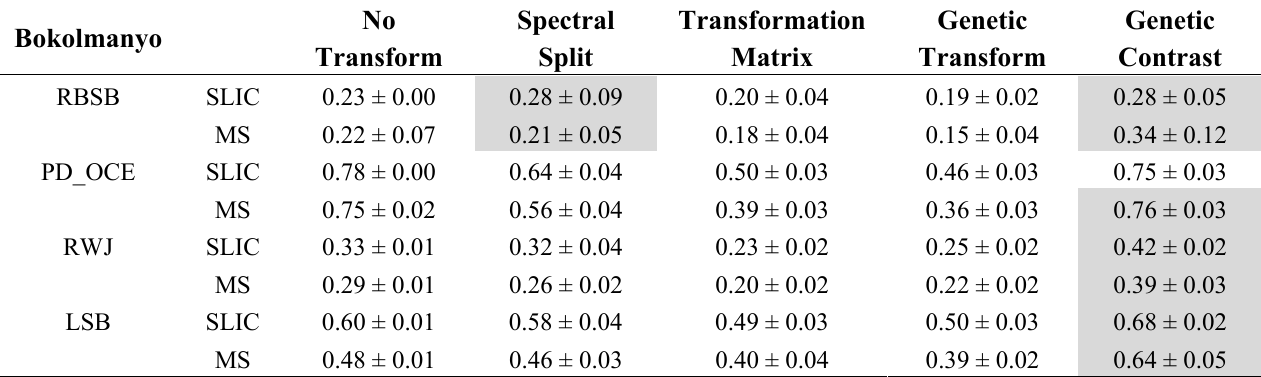
Table 4. Bokolmanyo site results.